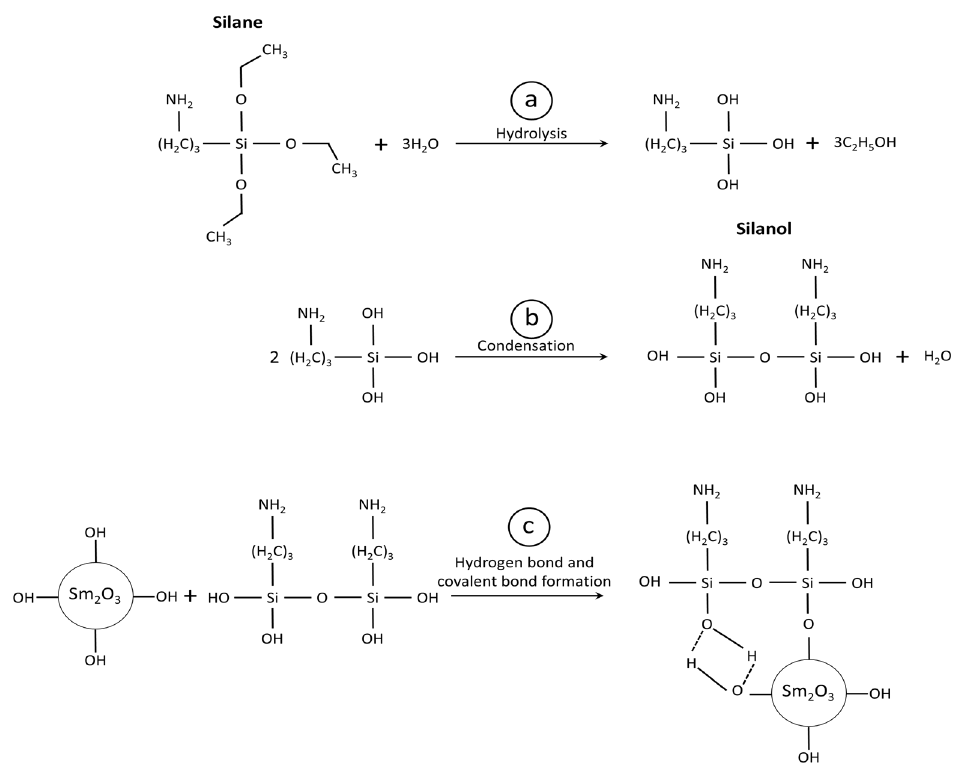
Figure 3. Schemes showing mechanisms of grafting KBE903 on surface of Sm 2 O 3 , including ( a ) hydrolysis, ( b ) condensation, and ( c ) hydrogen bond and covalent bond formation.